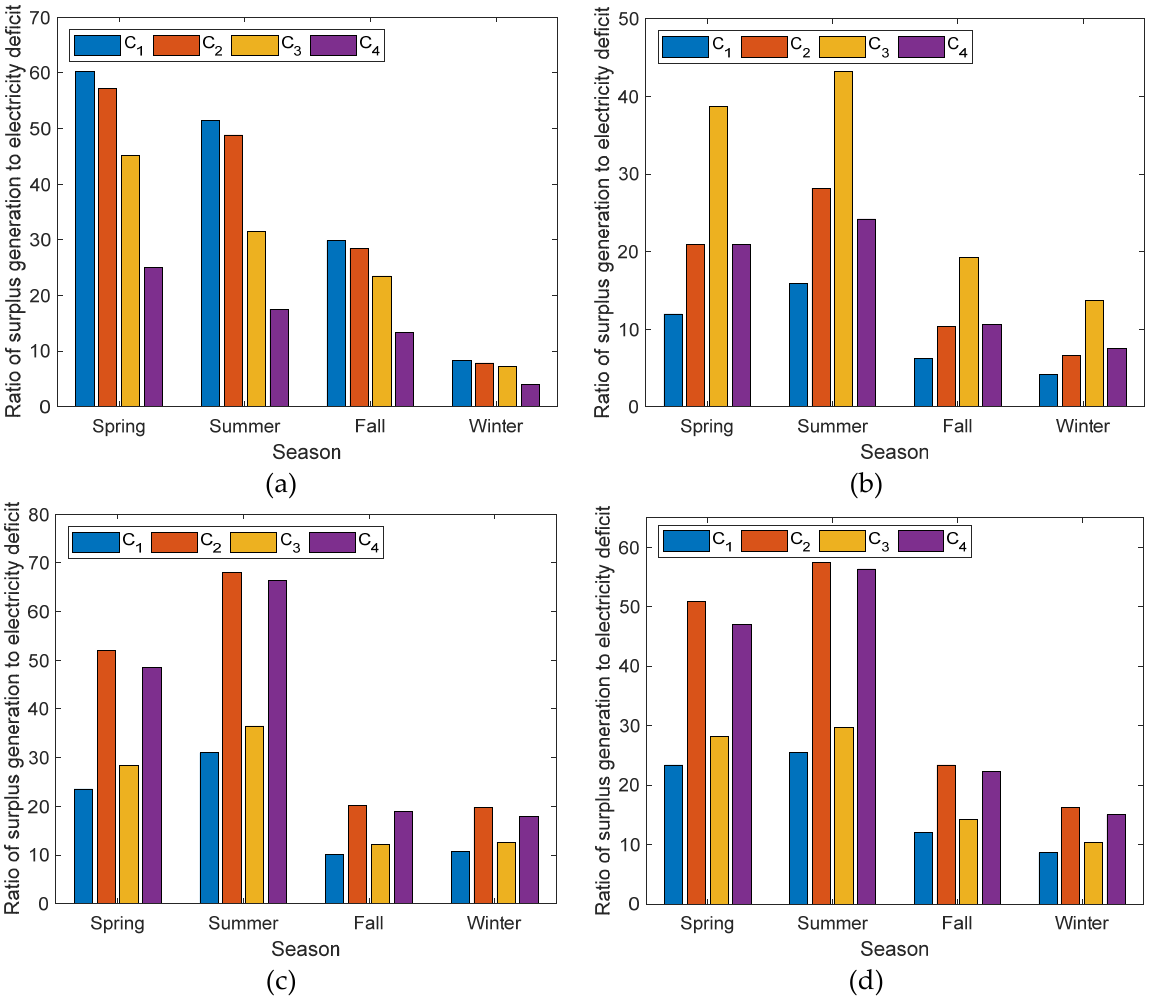
Figure 10. Ratio surplus generation to electricity deficit for various NU combinations for ( a ) S1 − A, ( b ) S1 − B, ( c ) S1 − C, and ( d ) S1 − D scenarios.